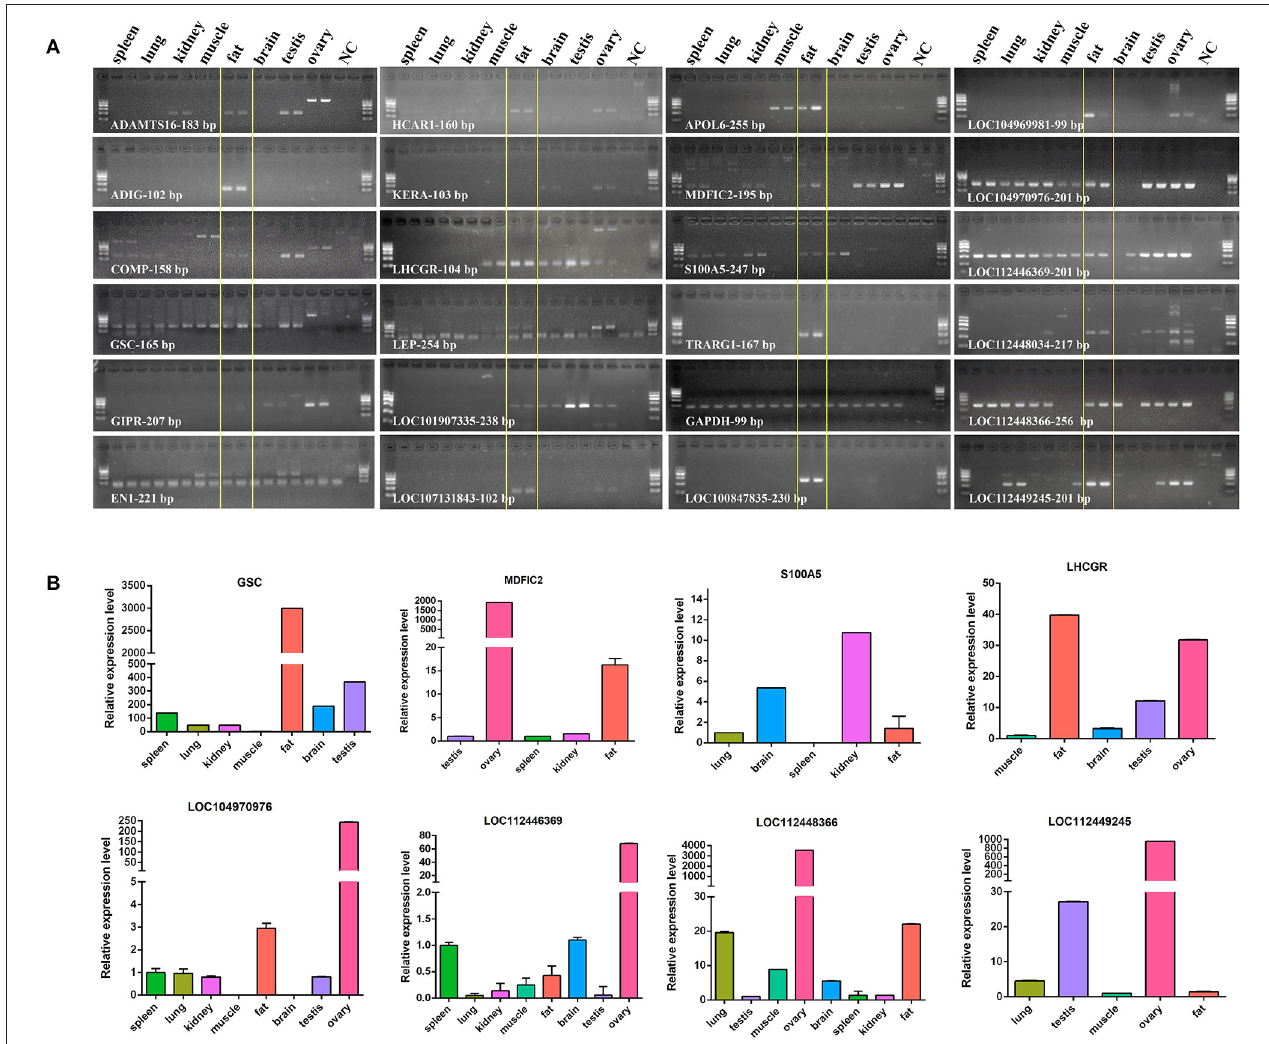
FIGURE 10 | Expression profiles of genes highly and specifically expressed in tissues. (A) , Detected by RT-PCR; NC, H 2 O; GAPDH was internal control; The marker was Marker I: 600 - 500 - 400 (the brightest line) - 300 - 200 - 100 bp; (B) , detected by qRT-PCR.